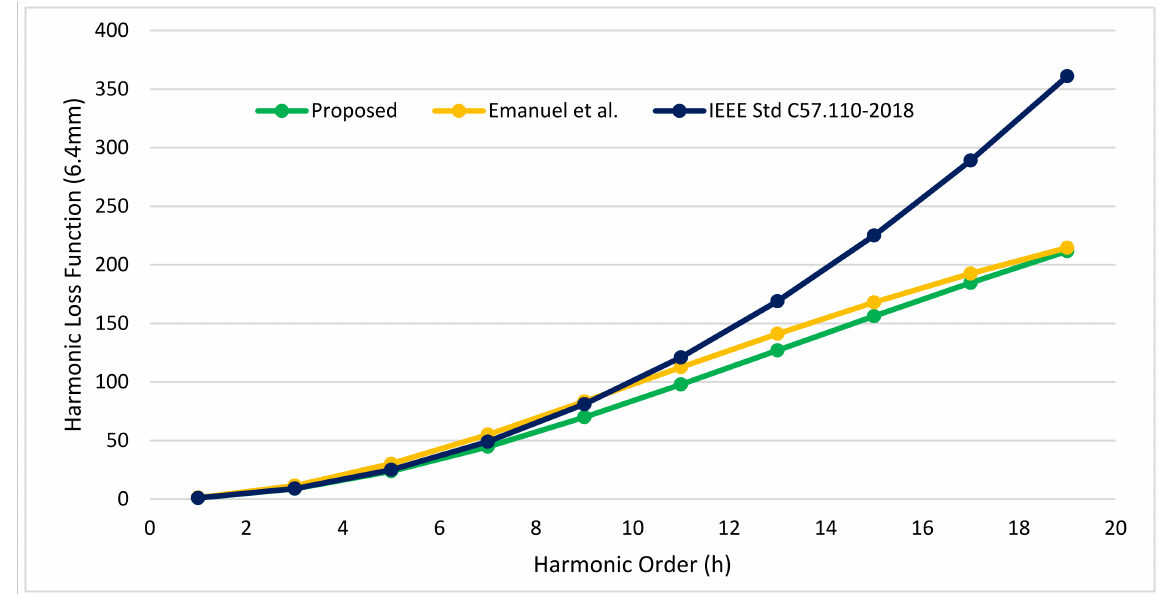
Figure 7. Harmonic loss factor comparison (conductor dimension of 6.4